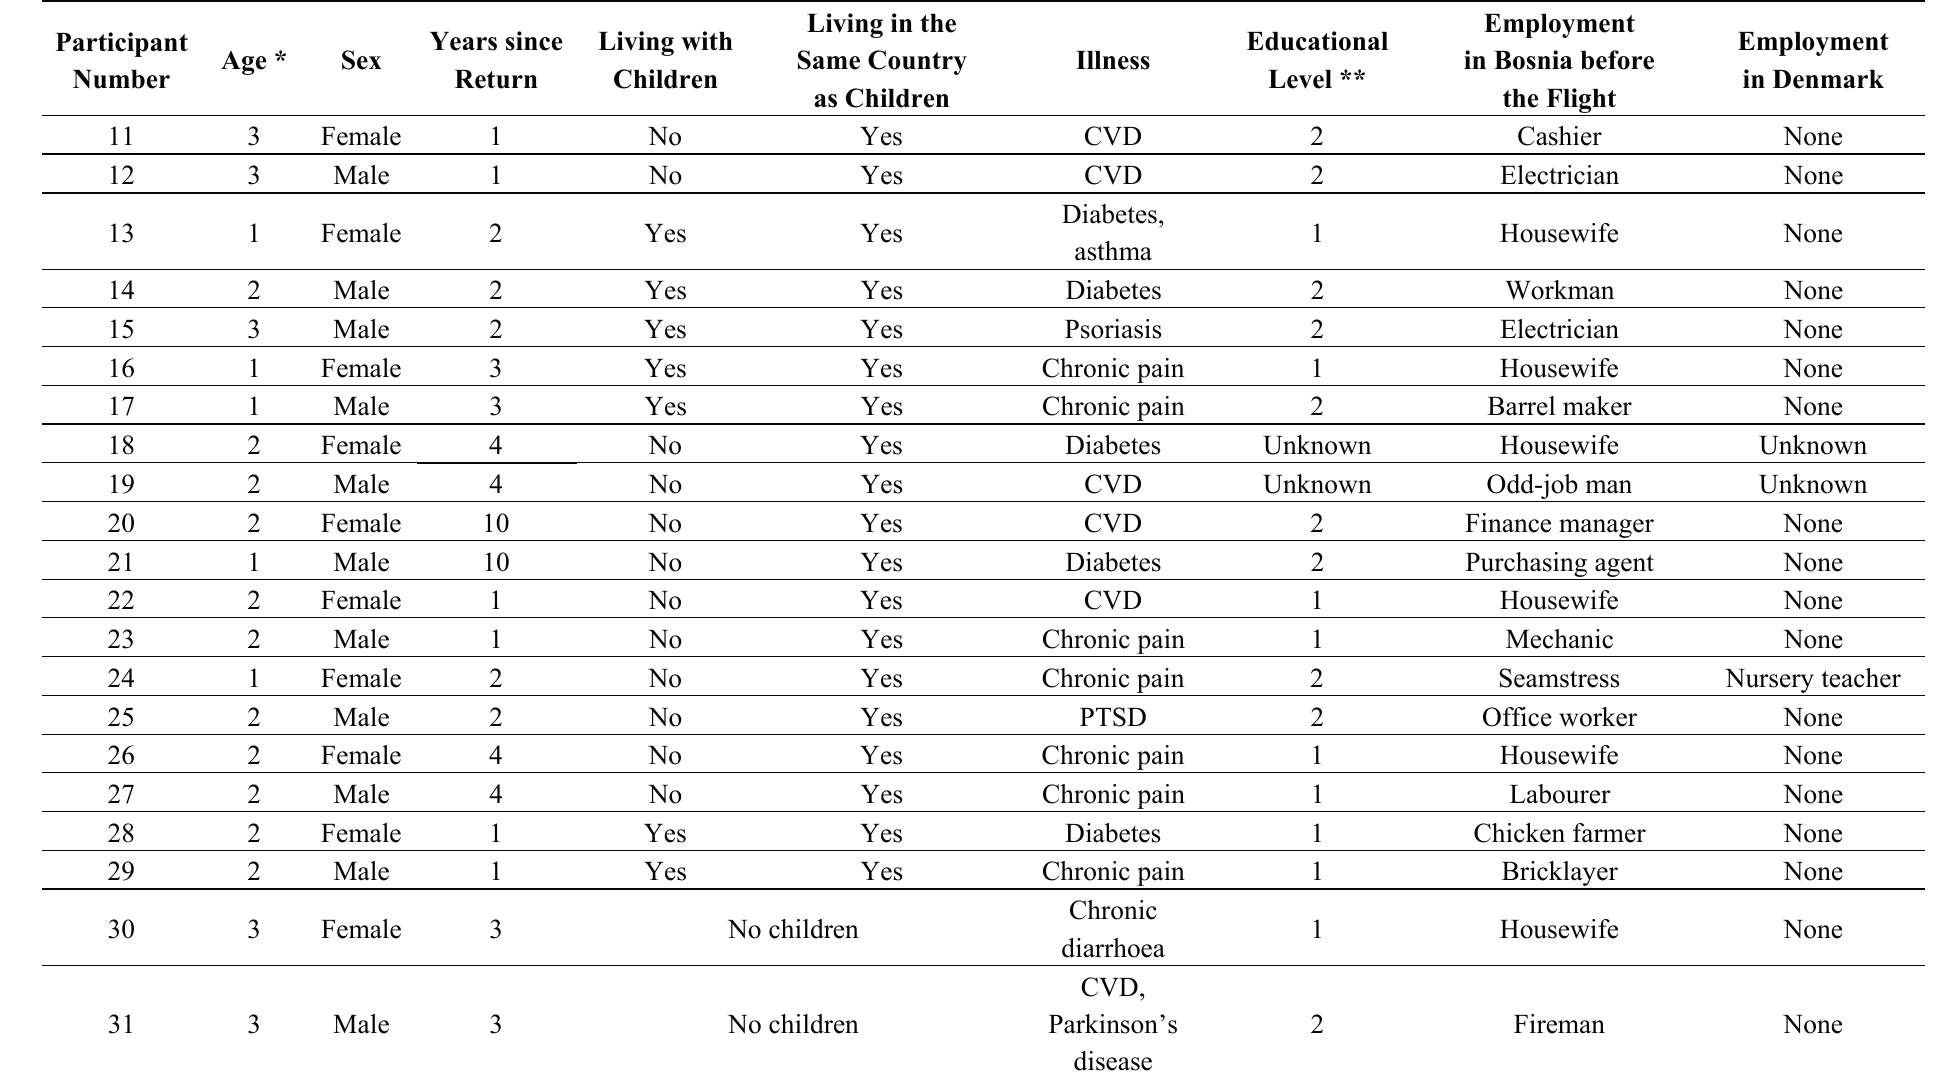
Table 2. Characteristics of informants residing in